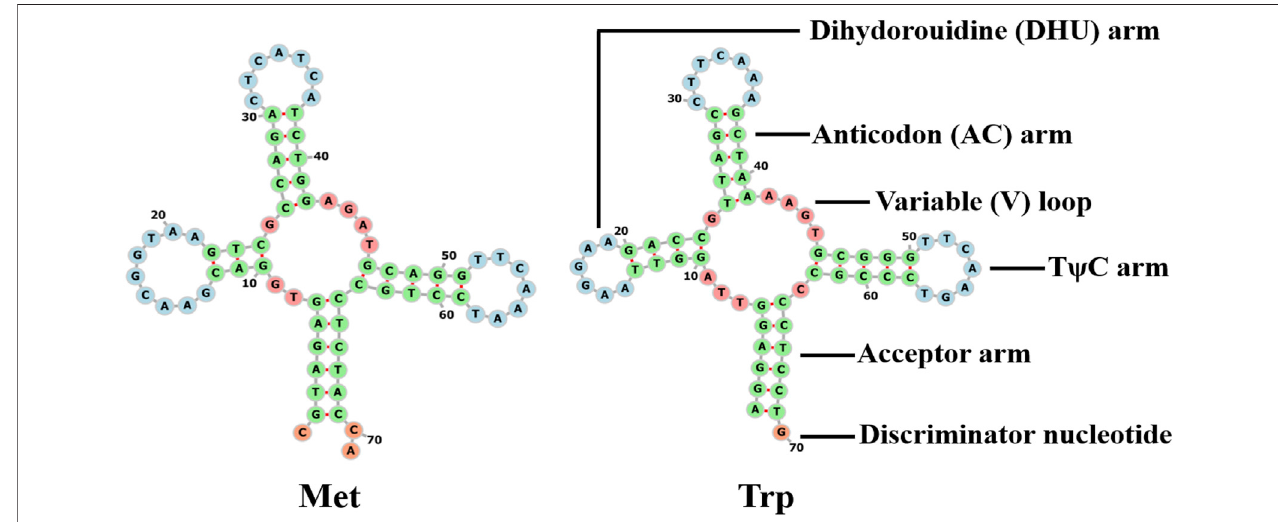
FIGURE 4 | Cloverleaf structure of the two inferred tRNAs in the mitogenomes of Galatheanthemum sp. MT-2020 mitogenomes.